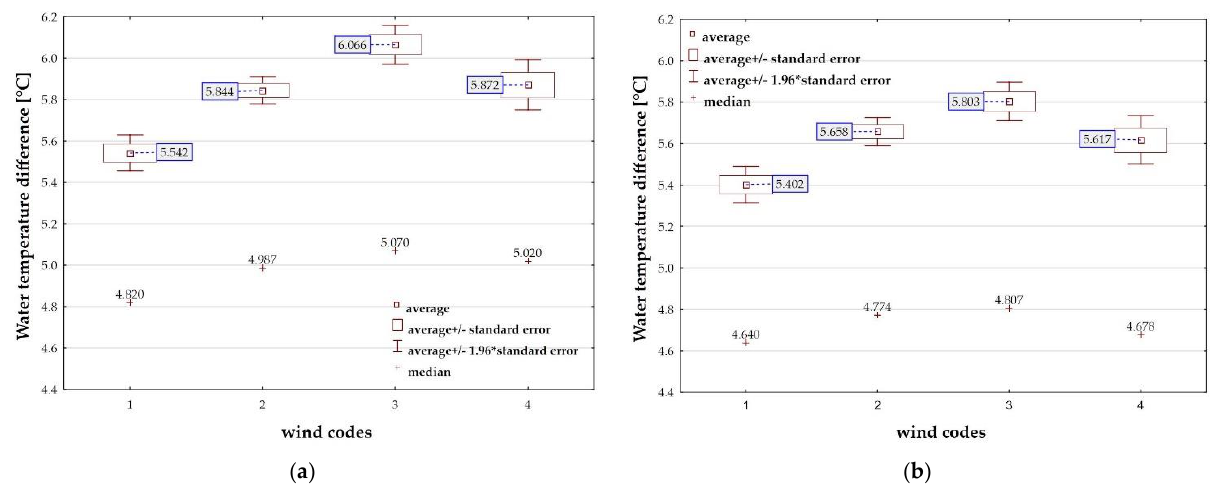
Figure 9. The effect of wind velocity on the water cooling level ∆𝑇 𝑤 , ( a ) power unit 5; ( b ) power unit 6. Source: own elaboration (Statistica software).